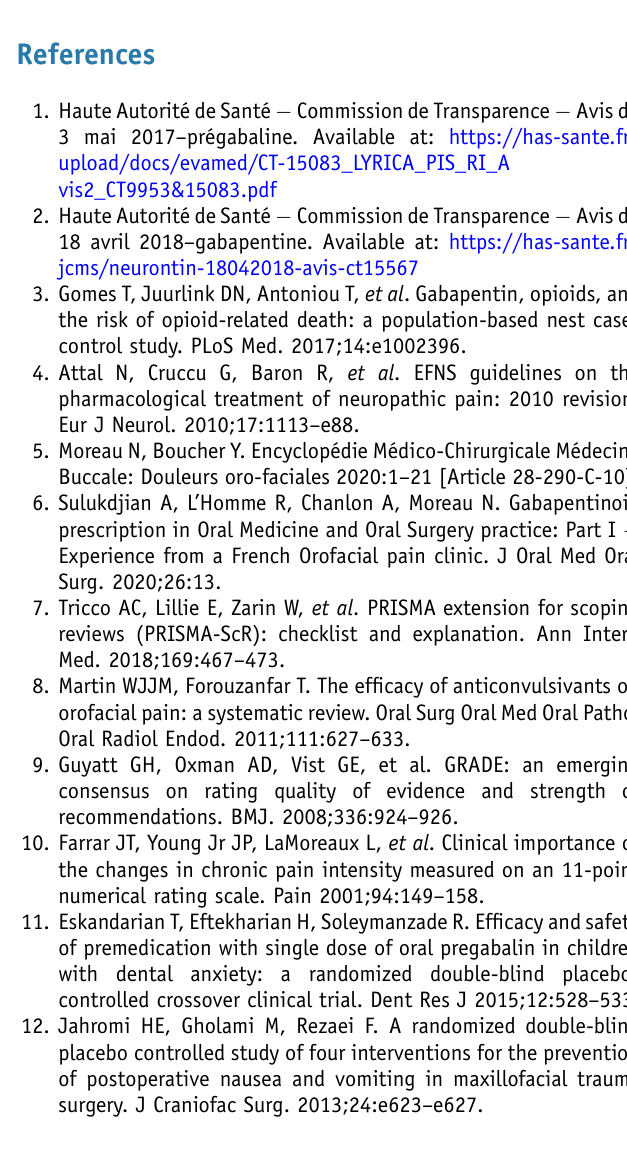
Fig. 5. Conclusions of the scoping review: indications, non-indications and contraindications of gabapentinoids in Oral Medicine and Oral Surgery (II = secondary indication, P =